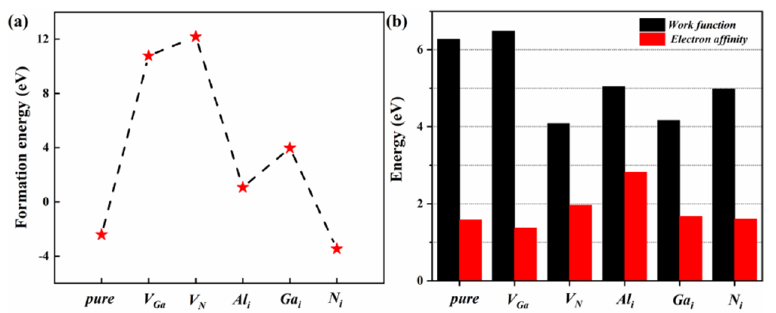
Figure 2. ( a ) Formation energies of Al 0 . 5 Ga 0 . 5 N nanowires with different defects. ( b ) Work function and electron affinity of Al 0 . 5 Ga 0 . 5 N nanowires with different defects.